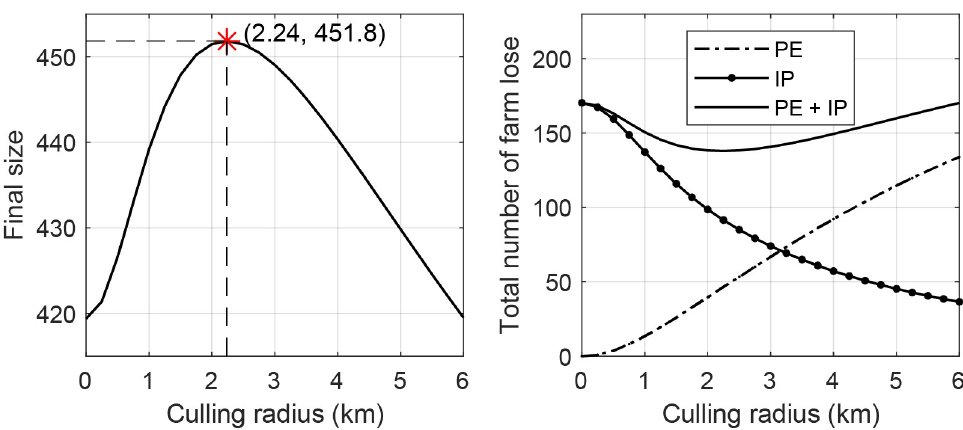
Fig 5. Impact of culling radius on the AI outbreak using the metapopulation model (Eq (2)) with all other parameters in Table 2. The left panel depicts the final size of susceptible farms with respect to culling radius. The right panel displays the total number of PE culling (dot-dashed), IP culling (dashed) and both (solid) with respect to culling radius. Note that when culling radius is 2.24 km , the final size of susceptible farms is maximized and the total number of culling is